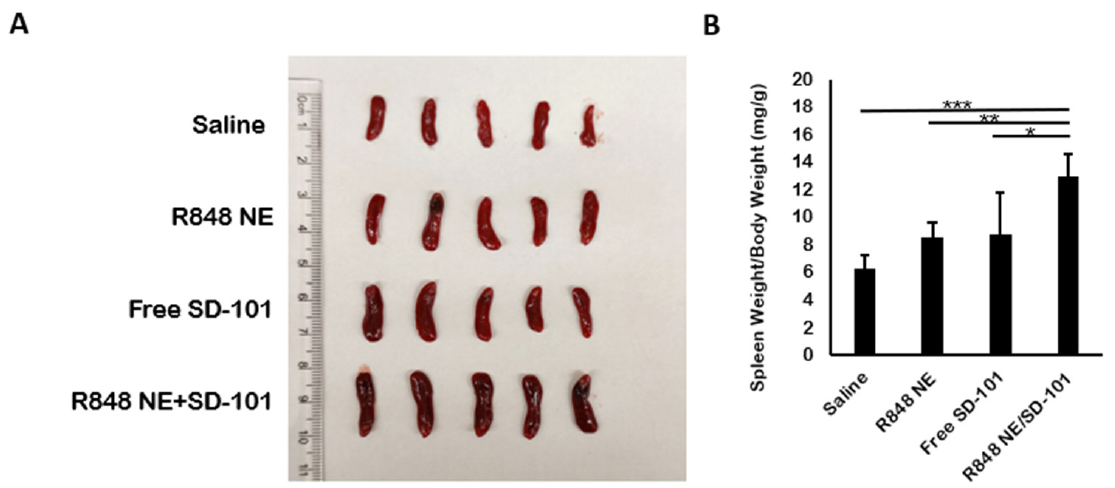
Figure 6. Changes in spleen weights from treated mice. ( A ) Spleen tissues were collected from mice at day 10 with measured ( B ) spleen weights, normalized to individual bodyweight ( n = 5). One-way ANOVA* p < 0.05, ** p < 0.01, *** p < 0.001.